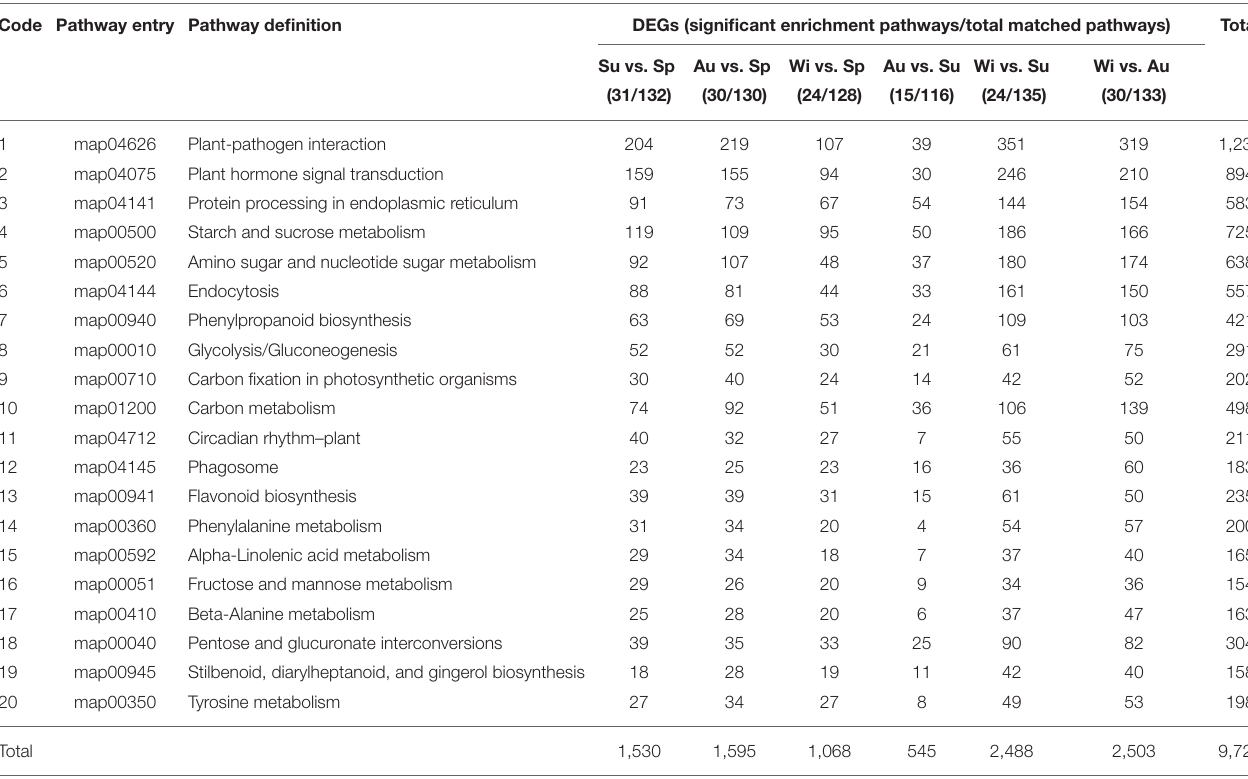
TABLE 3 | Kyoto encyclopedia of genes and genomes (KEGG) enrichment of differentially expressed genes (DEGs) with 20 top categories ( q < 0.05). Code Pathway entry Pathway